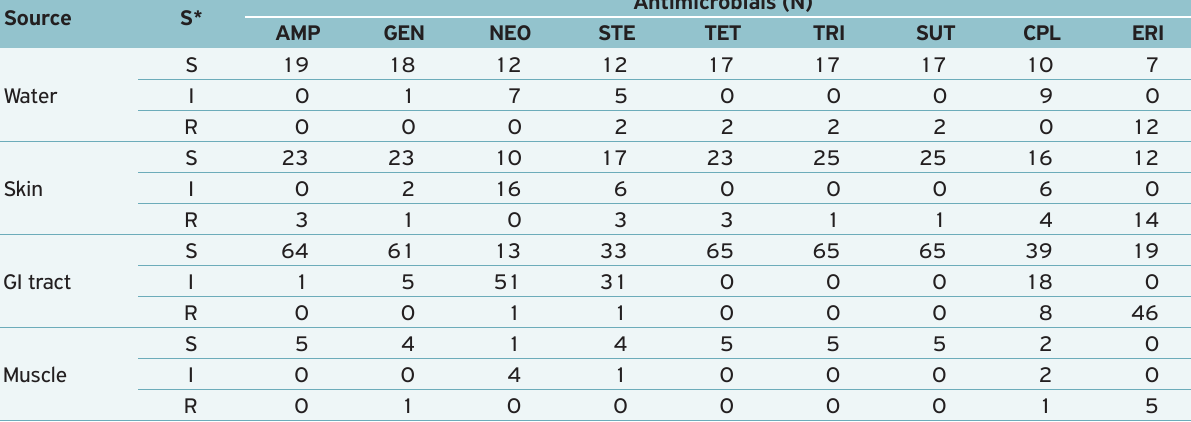
Antimicrobials (N)